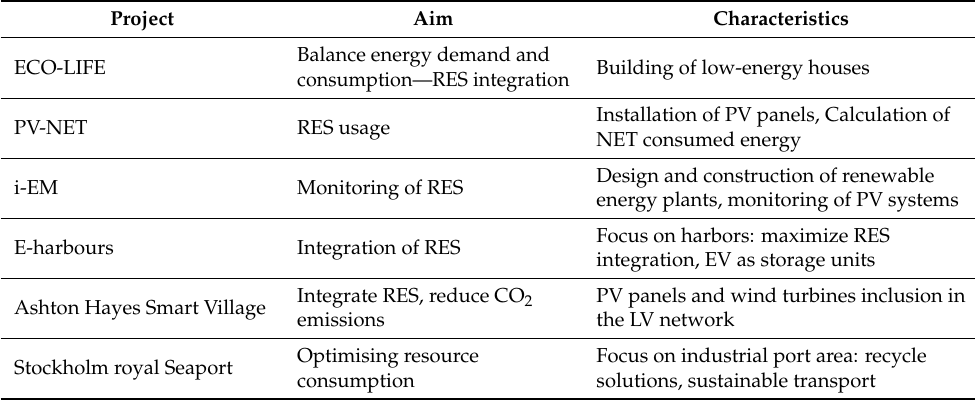
Figure 5. Integration of RES in the grid. Table 8. Summary of projects for Renewable Energy Sources—Integration and